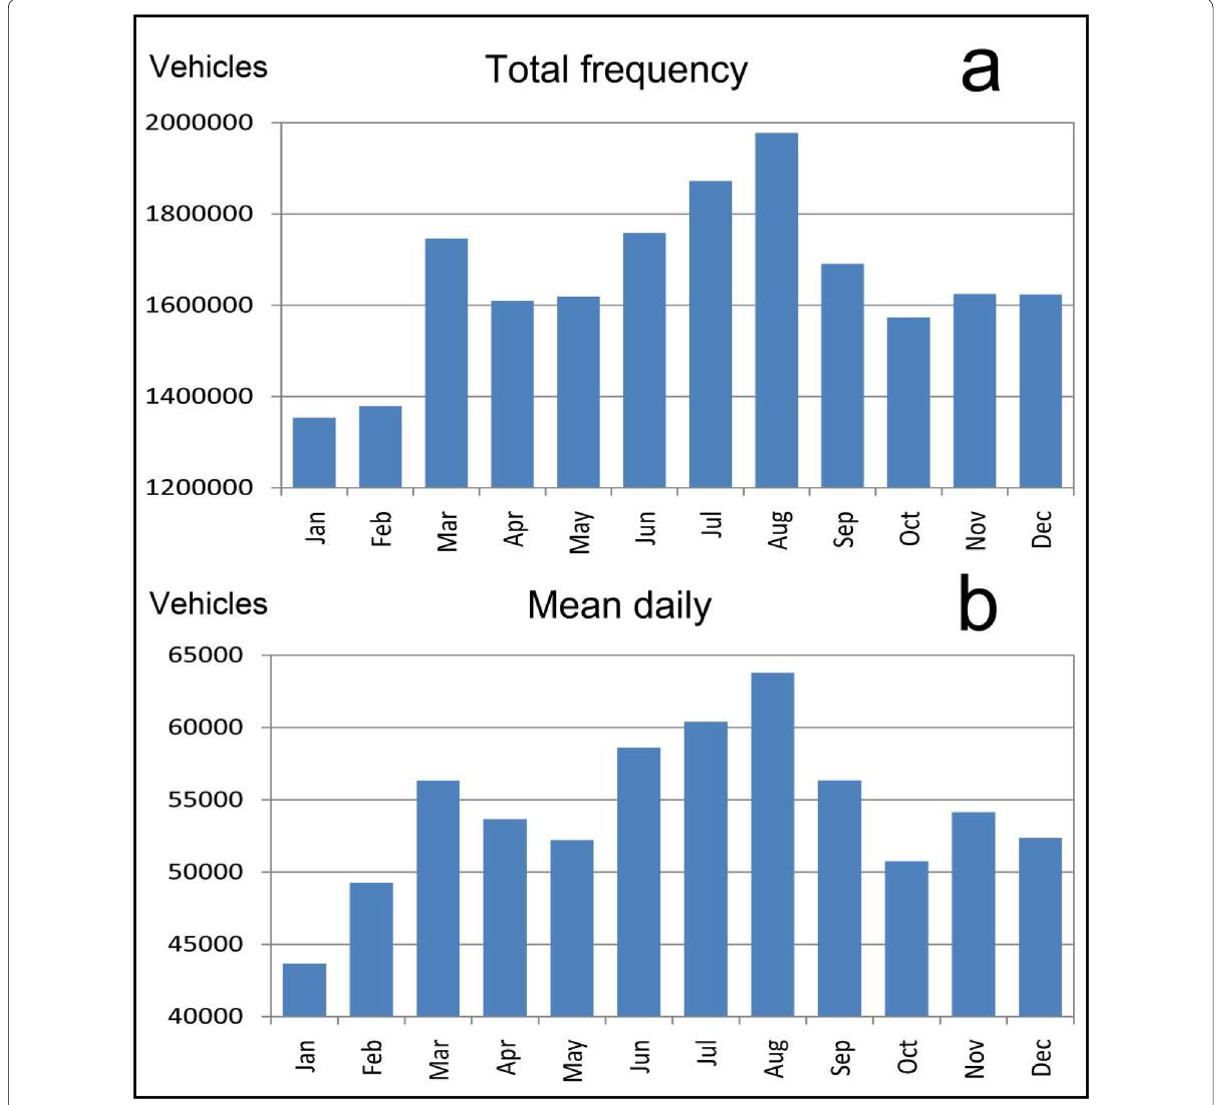
Fig. 4 Distribution of detecting vehicles in each month based on a total frequency and b mean daily frequency of vehicles in